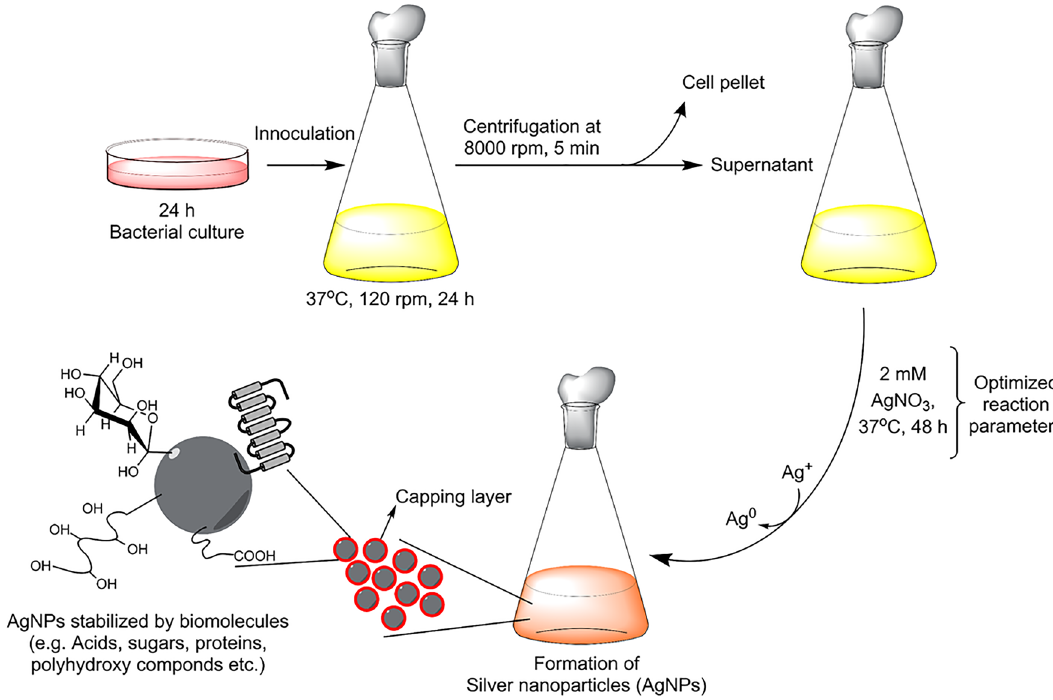
Figure 2. Schematics showing the stepwise procedure for AgNPs production from isolated Cedecea